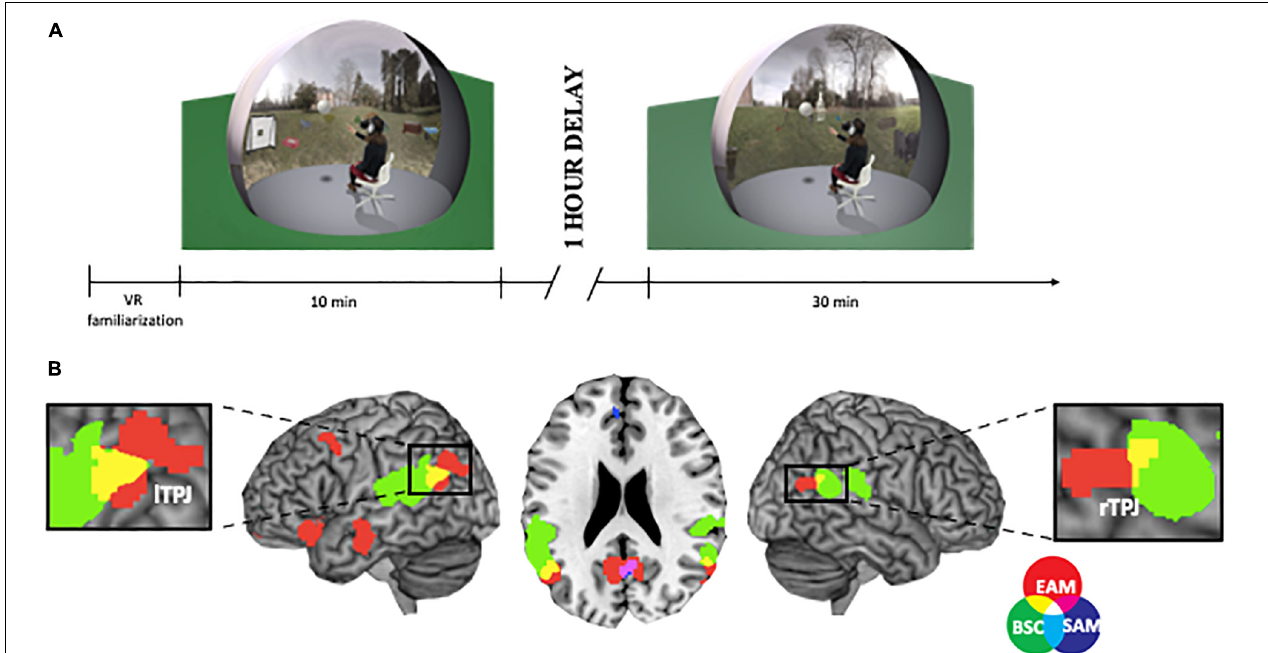
FIGURE 1 | (A) Study paradigm. First, participants incidentally learn the context of two different outside scenes (i.e., encoding session; 10 min). Participants were immersed back into the scenes with 1-h delay and were asked to perform a recognition task and subjective confidence ratings for each presented scene (i.e., retrieval session; 30 min). Before the actual study, subjects were seated in a chair, they were asked to put on the HMD and noise-canceling headphones to avoid external disturbances and familiarized themselves with the VR technology (10 min). (B) Visualization of the anatomical overlap between BSC fMRI analysis (i.e., self-location and first-person perspective) and EAM ALE analysis bilaterally in the parietal areas Label provided using the MRIcron. Within-cluster FEW-corrected p < 0.05 with p < 0.001 (uncorrected) as the cluster forming